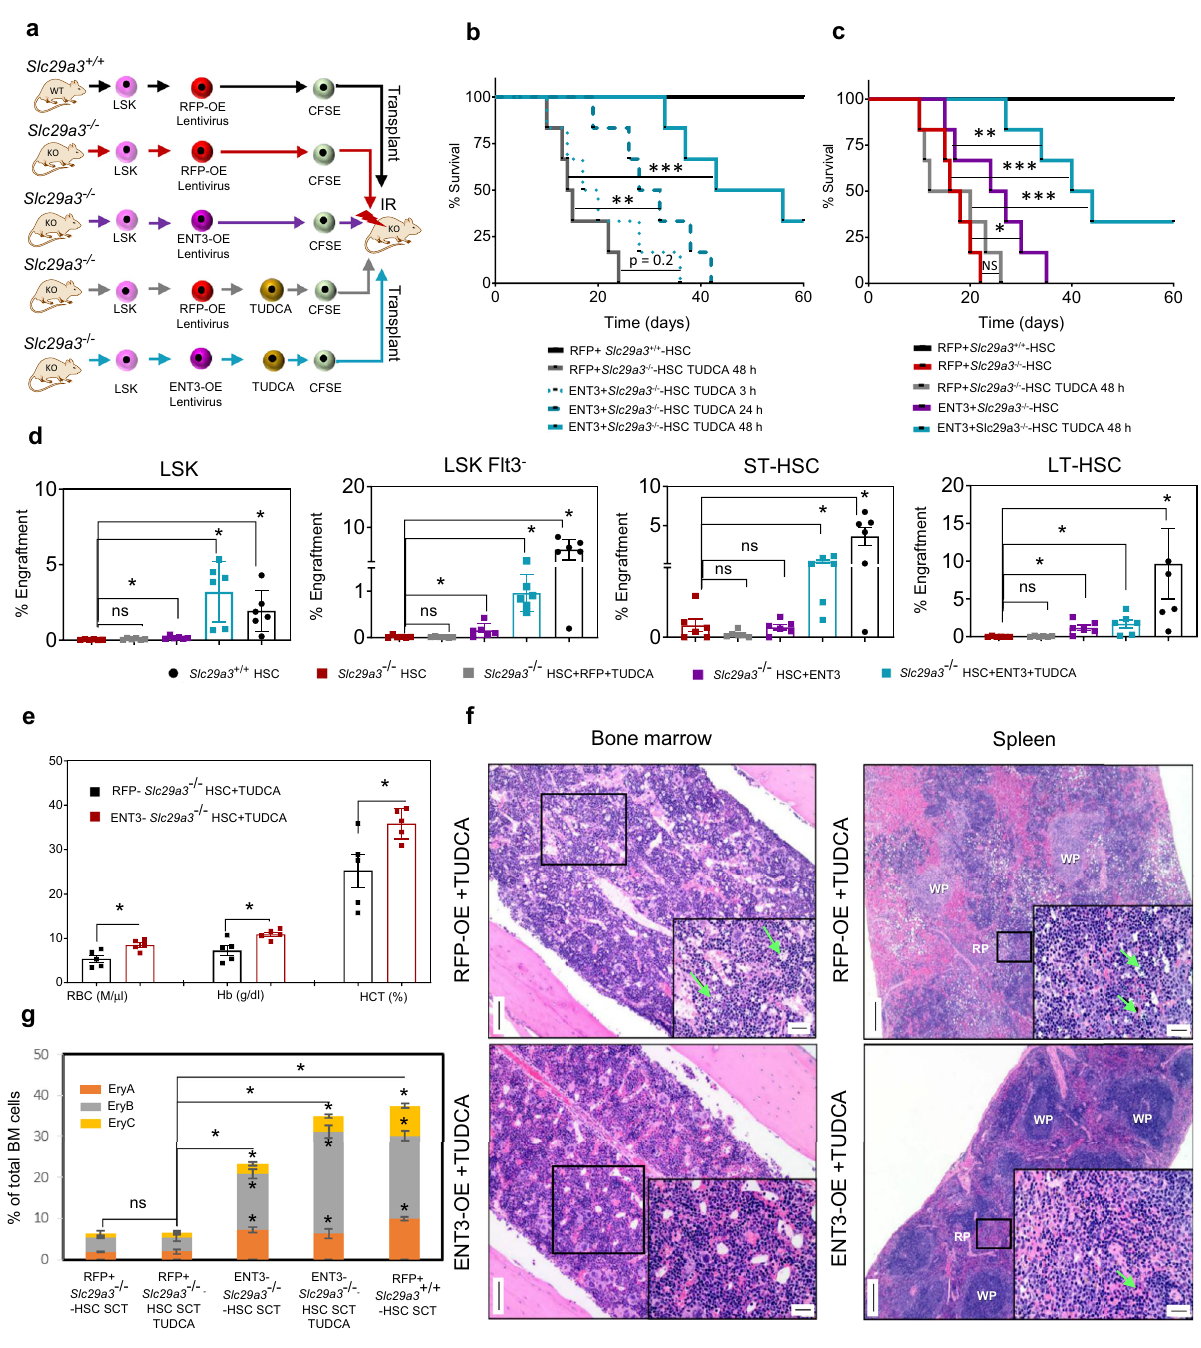
Methods Chemicals, reagents, and antibodies . Bile acid standards viz. cholic acid (CA), ursodeoxycholic acid (UDCA), deoxycholic acid (DCA), hyocholic acid (HCA), chenodeoxycholic acid (CDCA), alpha-muricholic acid ( α -MCA), beta-muricholic acid ( β -MCA), omega-muricholic acid ( ω -MCA), murocholic acid (Muro CA), dehydrocholic acid (DHCA), hyodeoxycholic acid (HDCA), taurocholic acid (TCA), TUDCA, tauro-alpha-muricholic acid (T- α -MCA), tauro-beta-muricholic acid (T- β -MCA), tauro-omega-muricholic acid (T- ω -MCA), taurodeoxycholic acid (TDCA), taurochenodeoxycholic acid (TCDCA), taurodehydrocholic acid (TDHCA), taurohyocholic acid (THCA), taurohyodeoxycholic acid (THDCA), glychocolic acid (GCA),glycoursodeoxycholic acid (GUDCA), glycochenodeoxy- cholic acid (GCDCA), glycodeoxycholic acid (GDCA), glycodehydrocholic acid (GDHCA), glycohyocholic acid (GHCA), and glycolithocholic acid (GLCA) were procured from Steraloids (Newport, RI, USA). Additionally, deuterated bile acid standards, i.e, taurocholic acid-d4 were obtained from Cayman Chemicals (Ann Arbor, MI, USA); TUDCA-d4 was purchased from Sigma-Aldrich (St. Louis, MO, USA). Internal standards viz. reserpine, 4-nitrophenol, 4 D -cholic acid and 4 D -